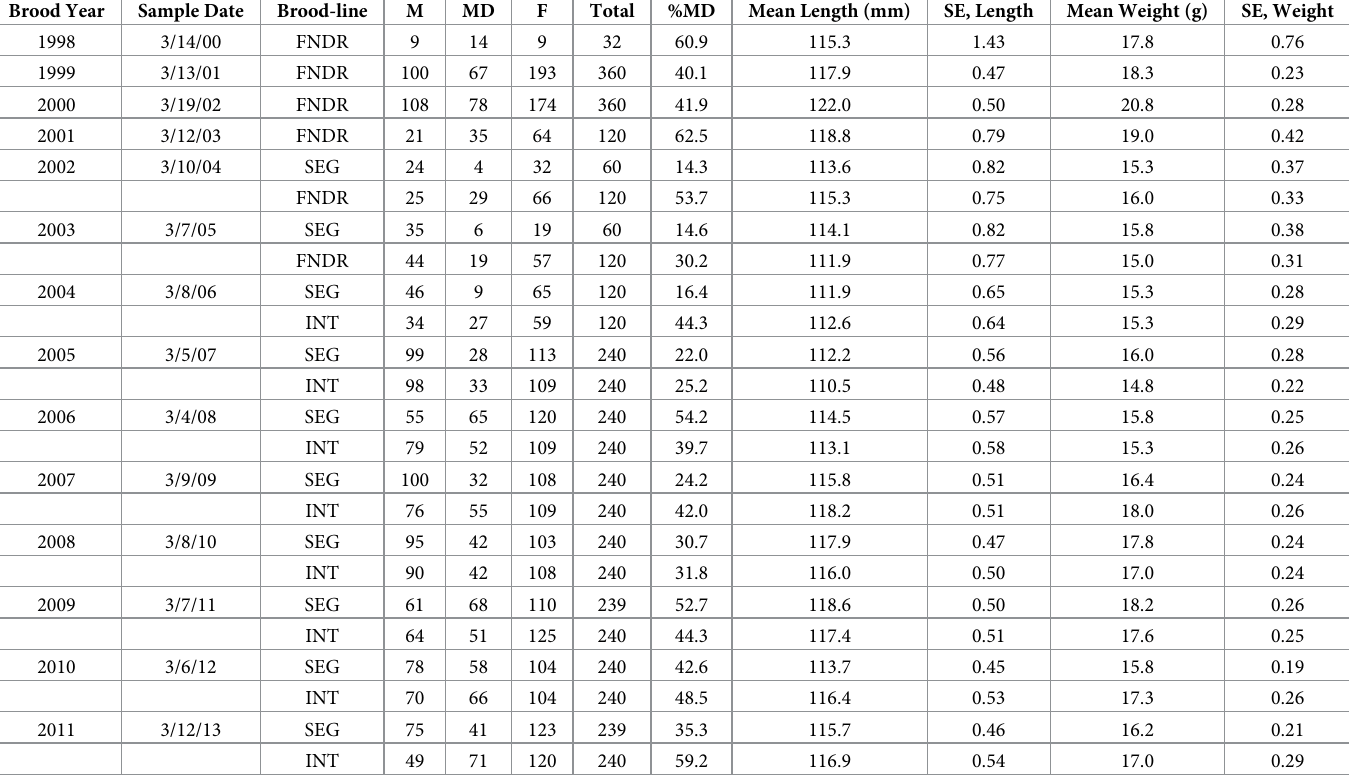
Table 2. Population summary (sex counts, mean size) from age-2 minijack assessments at Clark Flat acclimation